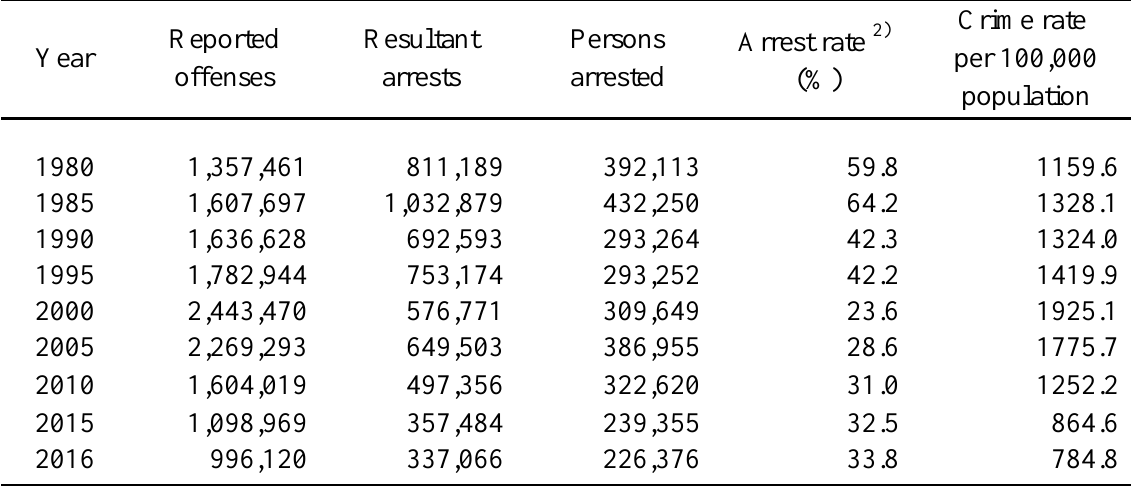
Trends in Crime 1) (Penal code